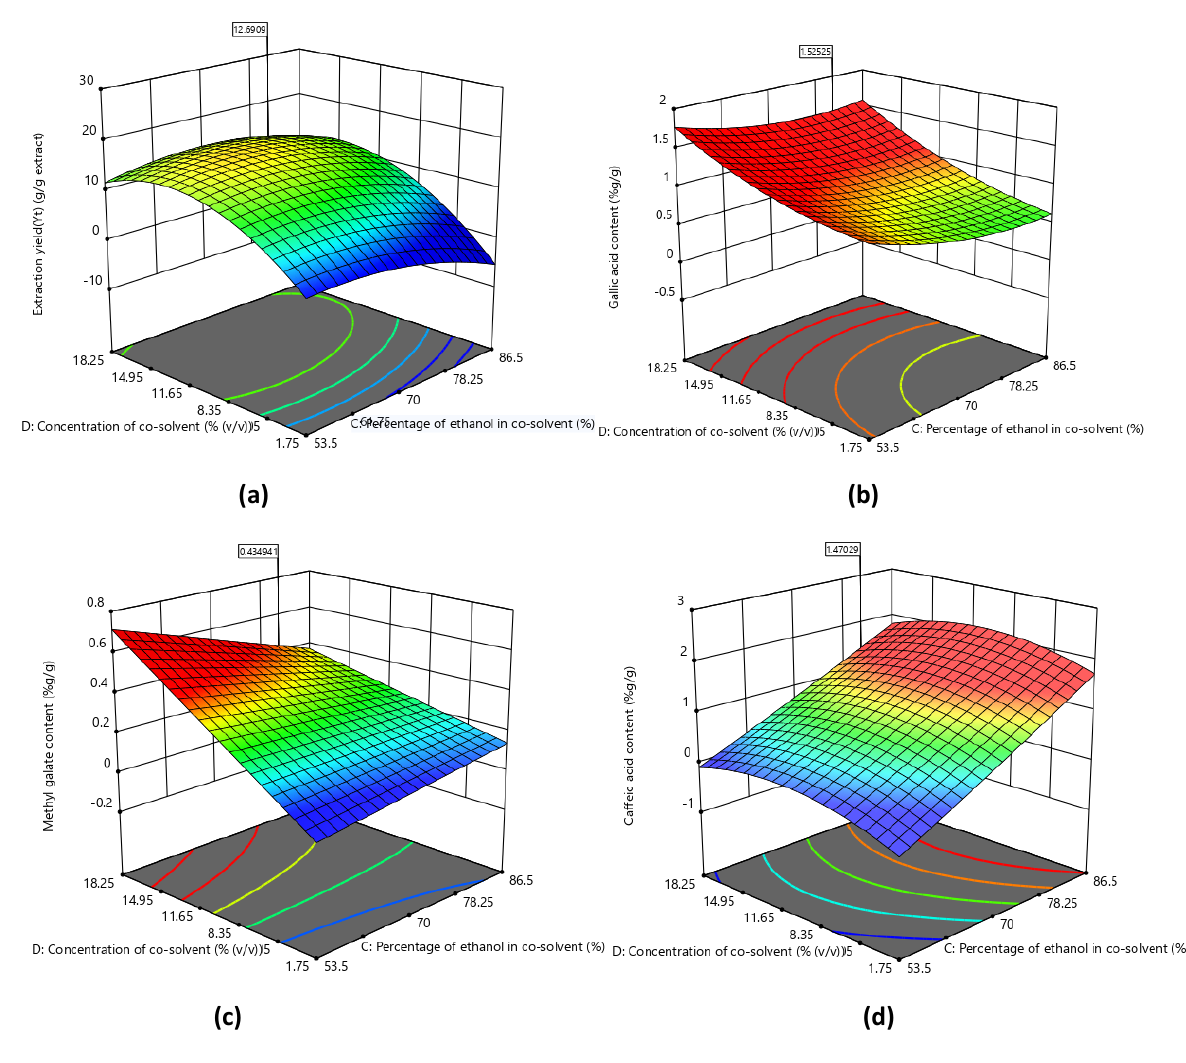
Figure 6. Effect of percentage of ethanol in co-solvent and co-solvent concentration on ( a ) extraction yield, ( b ) gallic acid content, ( c ) methyl gallate content, and ( d ) caffeic acid